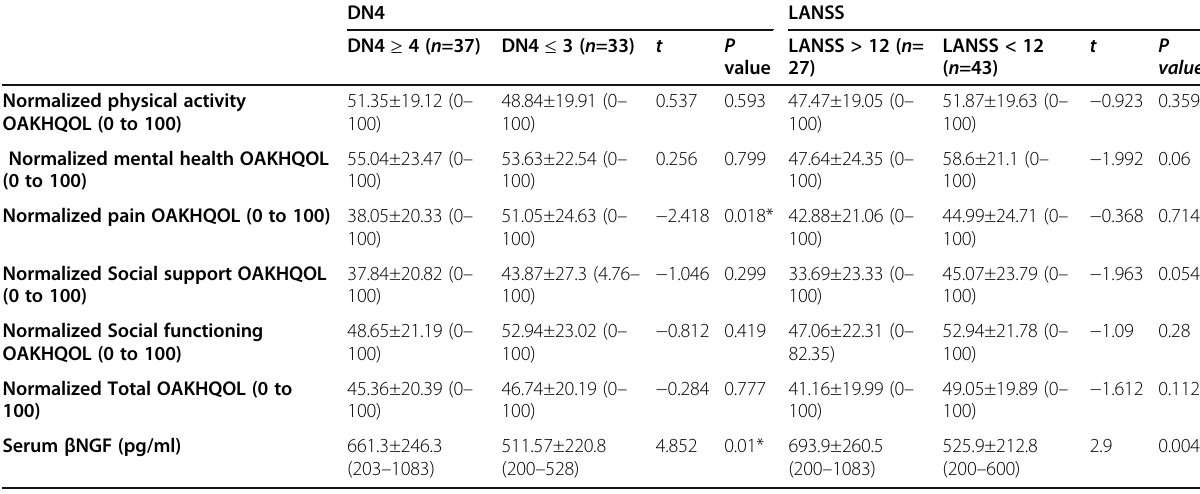
Table 5 Quality of life and serum β NGF levels in patients with neuropathic pain versus those with non-neuropathic pain